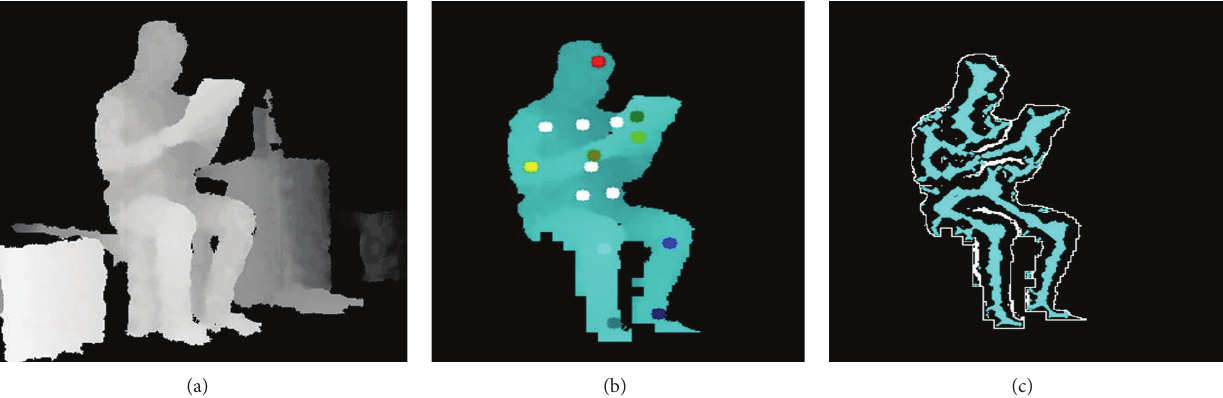
Figure 3: Depth images preprocessing as (a) raw depth images having noisy background, (b) labelled human silhouette, and (c) ridge body